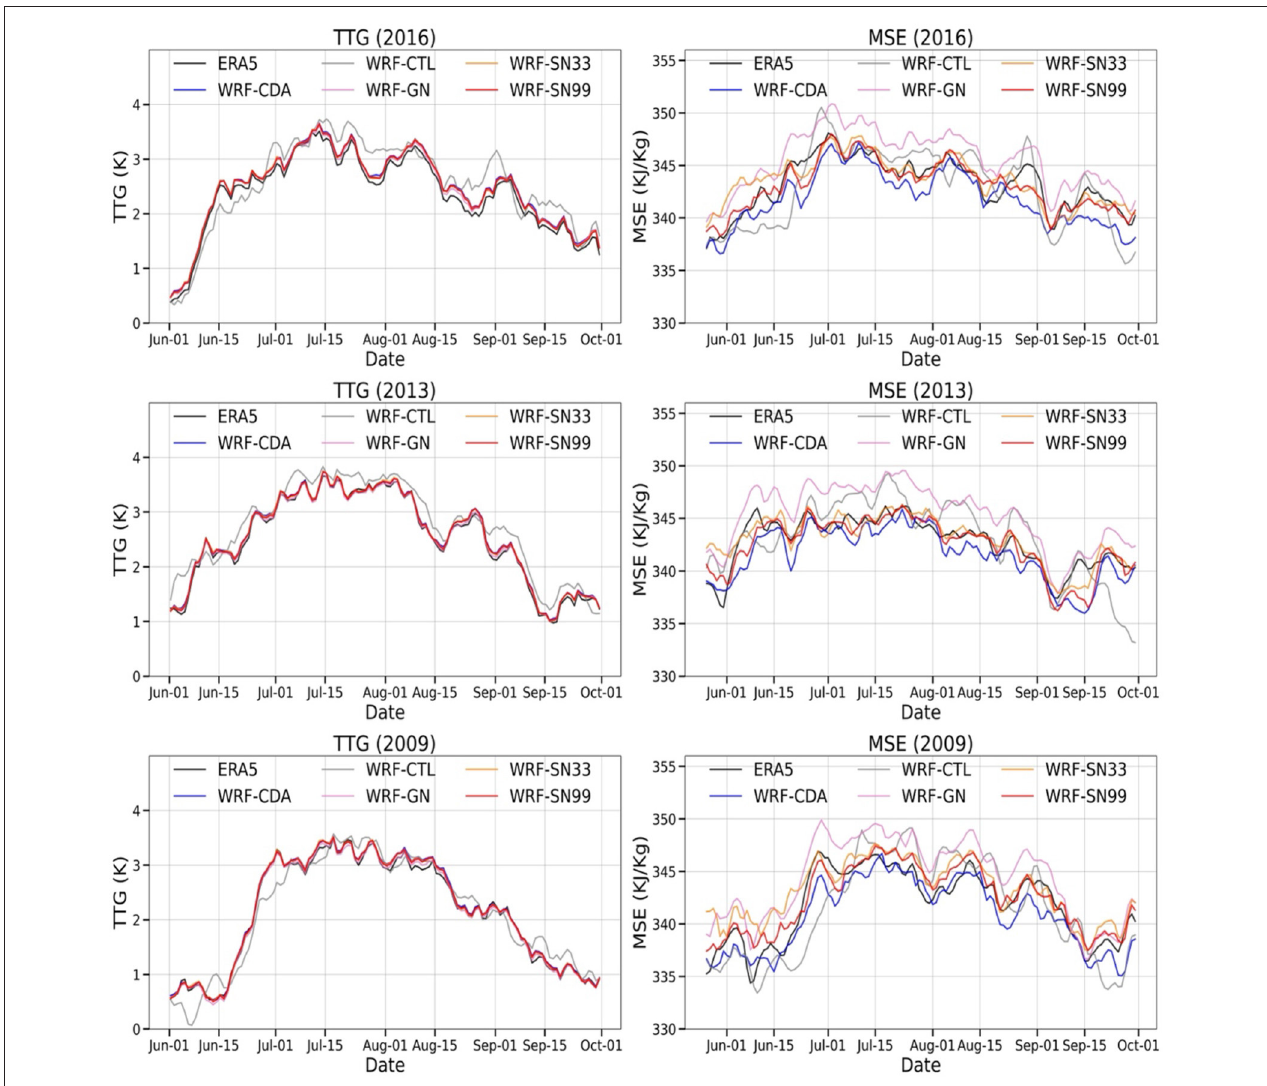
FIGURE 9 | The time series of the tropospheric temperature (averaged between 700 and 200 hPa) gradient (K) is the differences in the mean tropospheric temperature averaged over the regions 40–100 ◦ E; 5–35 ◦ N and 40–100 ◦ E; 15 ◦ S − 5 ◦ N (left panel) for the normal (2016), excess (2013), and drought (2009) Indian summer monsoon years. The right panel is same as the left panel but for mean moist static energy (MSE, KJ/Kg) averaged over central